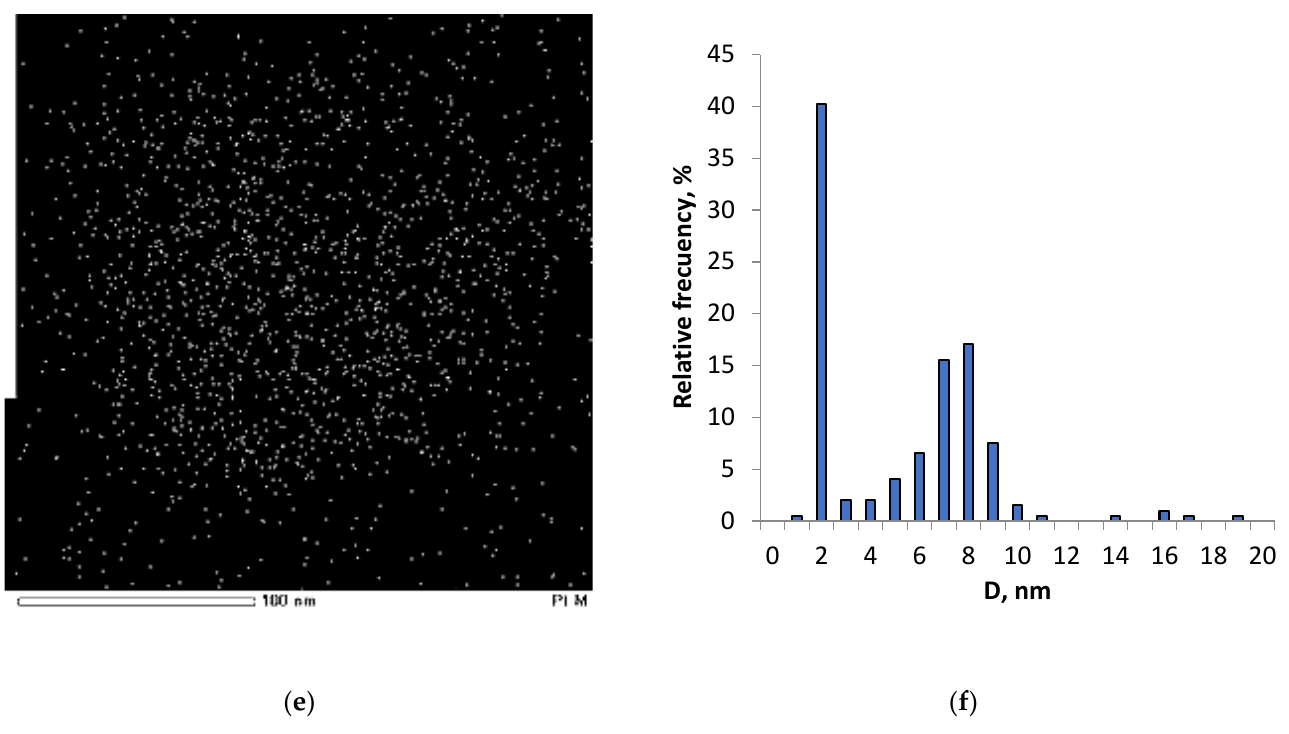
Figure 2. ( a , b ) TEM images; ( c ) Si, ( d ) Co, and ( e ) Pt EDX element distribution maps; and ( f ) particle size distribution of the 0.05Pt/2.5Co/Z-28 sample.